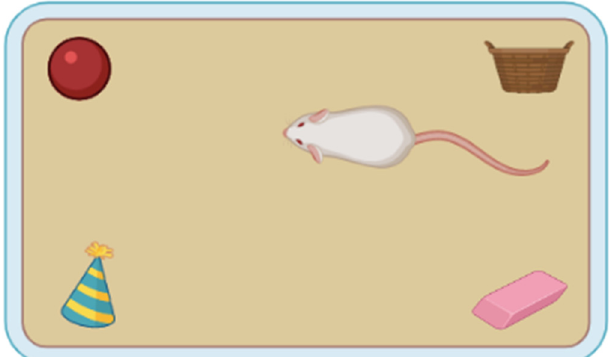
Figure 5. A mouse with four novel objects for the repetitive novel object contact task. Small toys/objects are used to evaluate mouse repetitive behaviour. Created with Biorender.com.